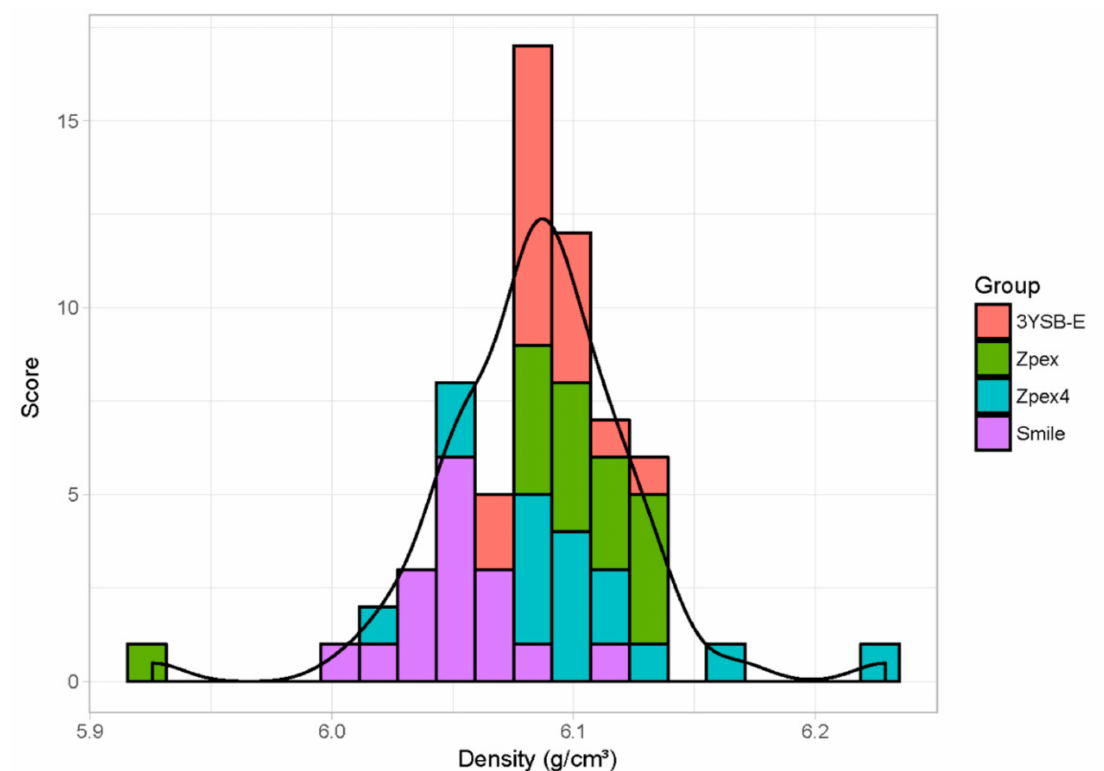
Figure 3. Range of densities for di ff erent specimens used in the transmittance test. The colors represent the di ff erent types of